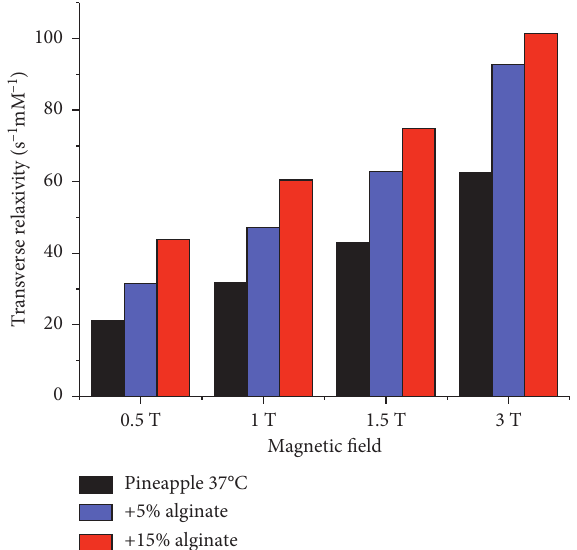
Figure 8: Transverse relaxivity of pineapple juice without and with alginate at 37 ° C.